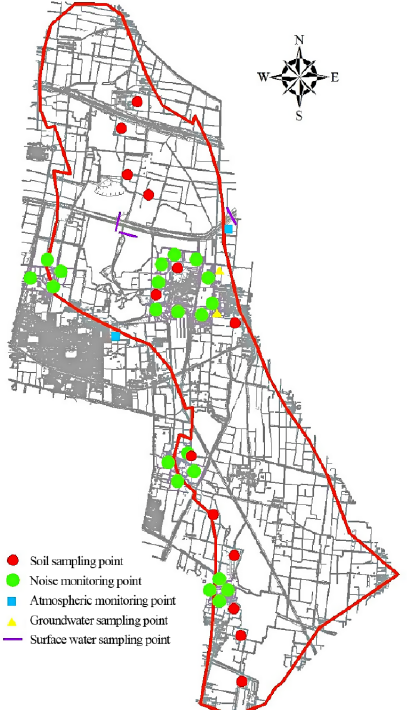
Figure 1. Layout of sampling and monitoring sample points.